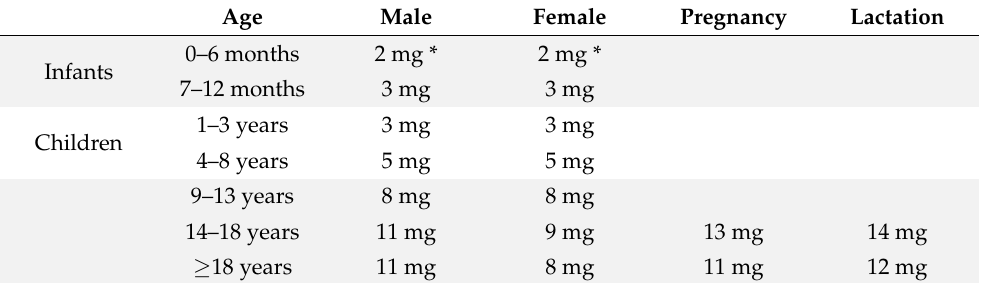
Table 1. Dietary Reference Intakes for Zinc.